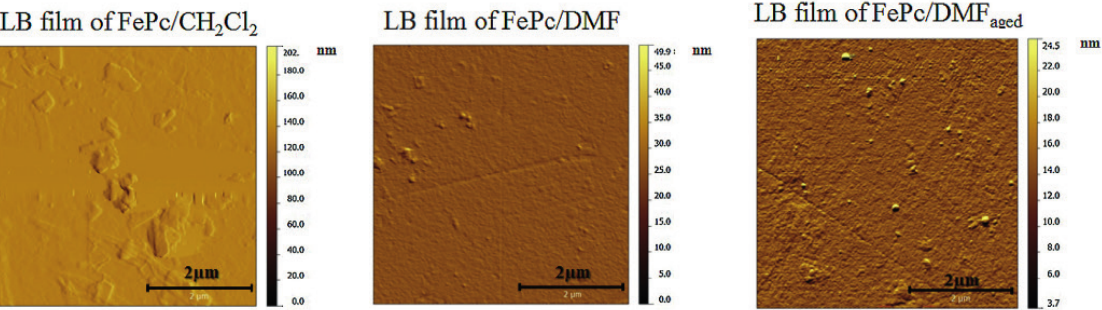
Cl , FePc/DMF and FePc/DMF aged LB fi lms (DMF 2 2